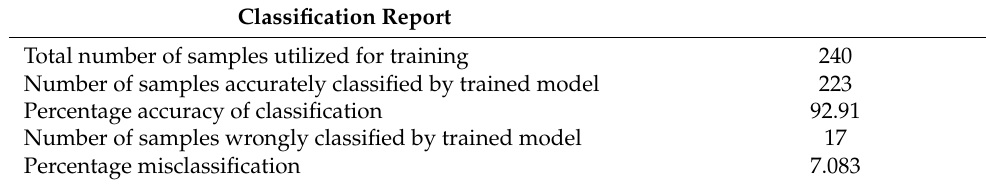
Table 2. Classification results summary considering cross-validation mode.